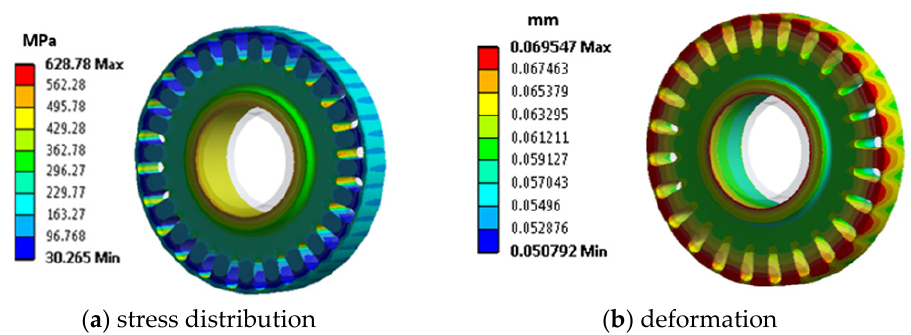
Figure 11. Stress distribution and deformation in CuNiSiCr End-Ring including centrifugal and copper bar load.